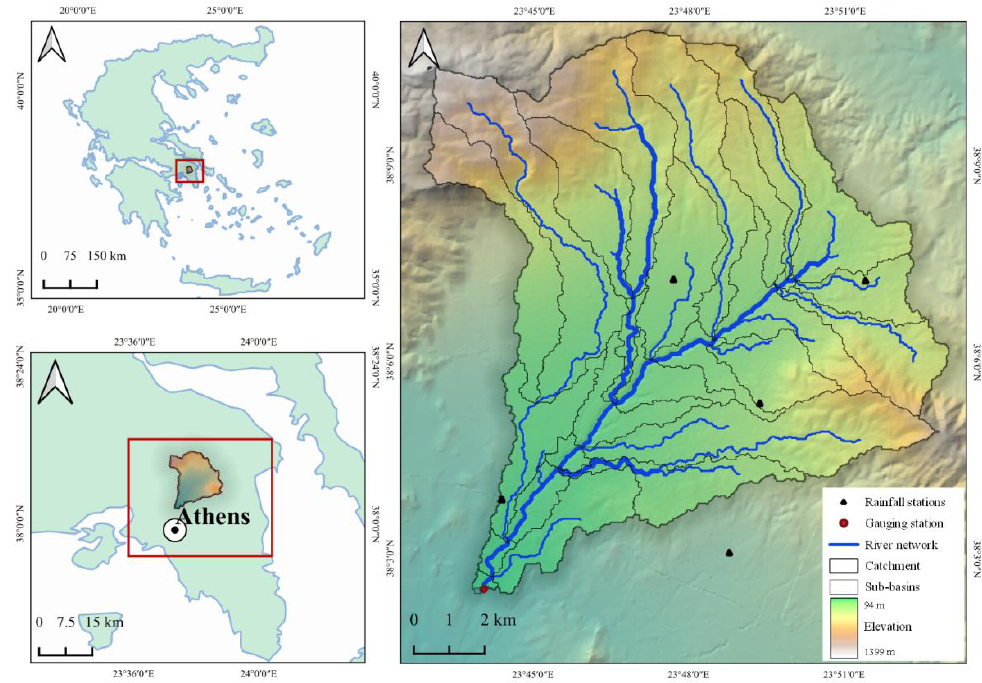
Figure 1. Location of Kifissos River sub-basin and monitoring stations (right), Athens metropolitan area (lower left), and zoom out display of Greece (upper left).